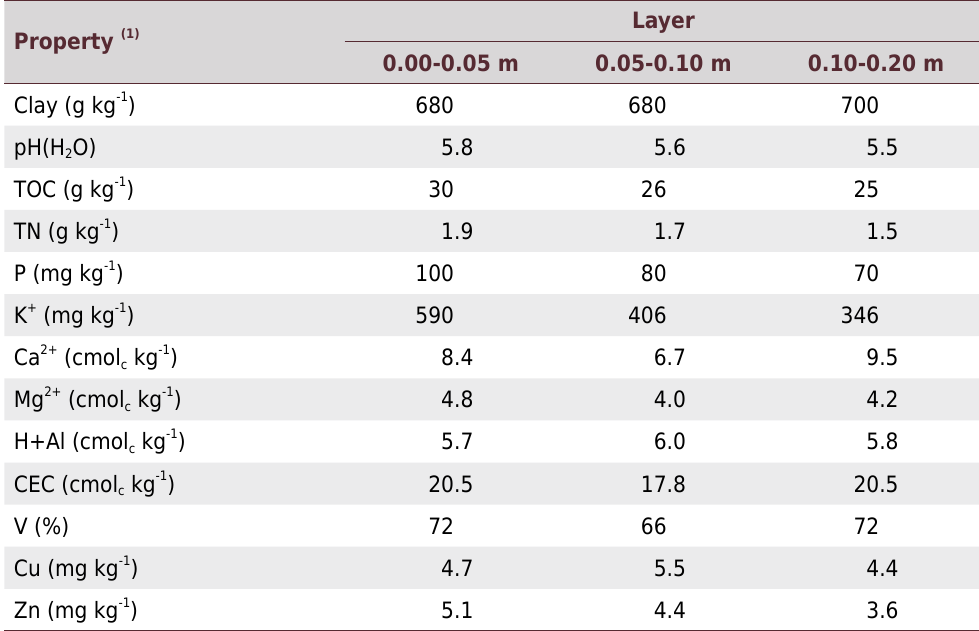
Table 1. Initial characterization of the Rhodic Kandiudox ( Nitossolo Vermelho Distroférrico ) in the 0.00-0.05, 0.05-0.10, and 0.10-0.20 m soil layers. Concórdia, Santa Catarina, Brazil Property